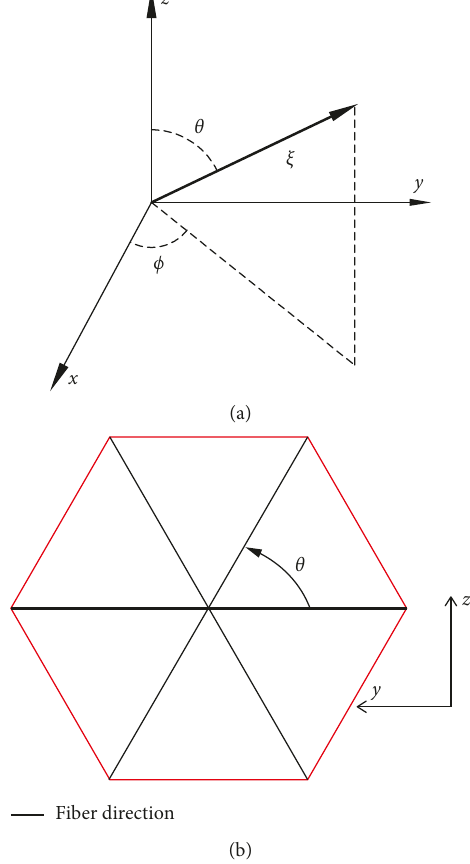
Figure 21: Bond angle in continuum (a) and lattice (b)